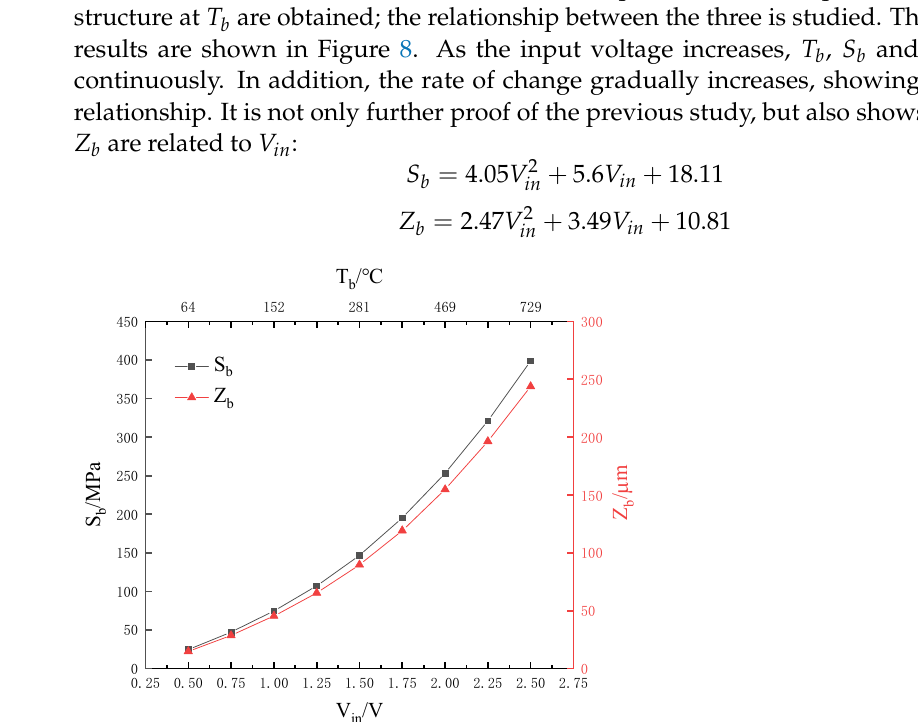
Figure 8. 𝑇 (cid:3029) , 𝑆 (cid:3029) , and 𝑍 (cid:3029) under different 𝑉 (cid:3036)(cid:3041) in II ‐ ECLC model.